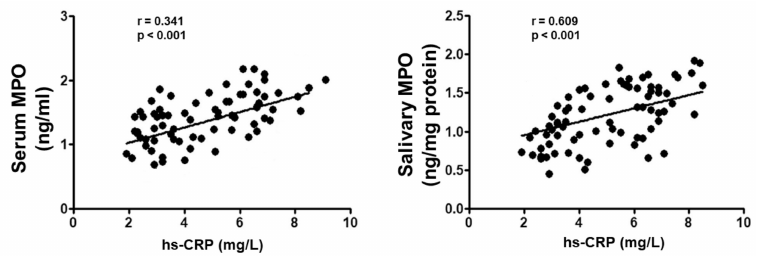
Figure 3. Analysis of correlation of serum and salivary MPO levels with c-reactive protein (CRP) in all patients.